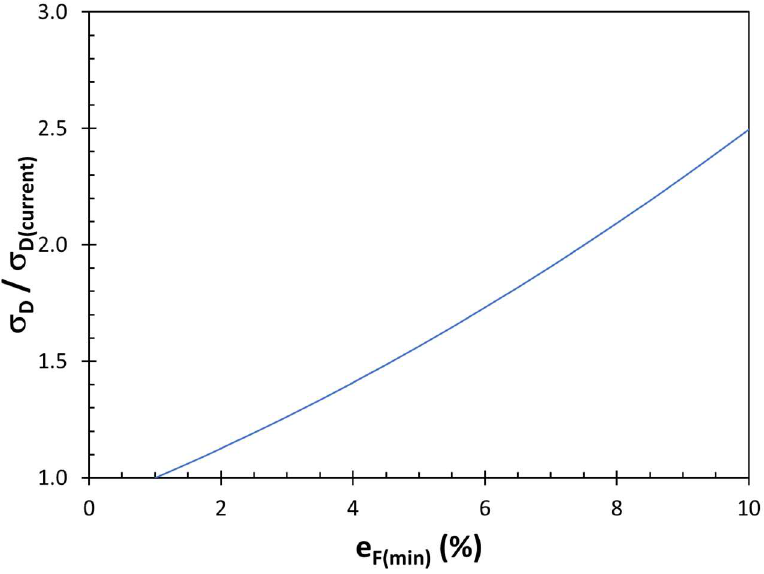
Figure 4. The change in normalized design strength with increasing minimum elongation requirement.